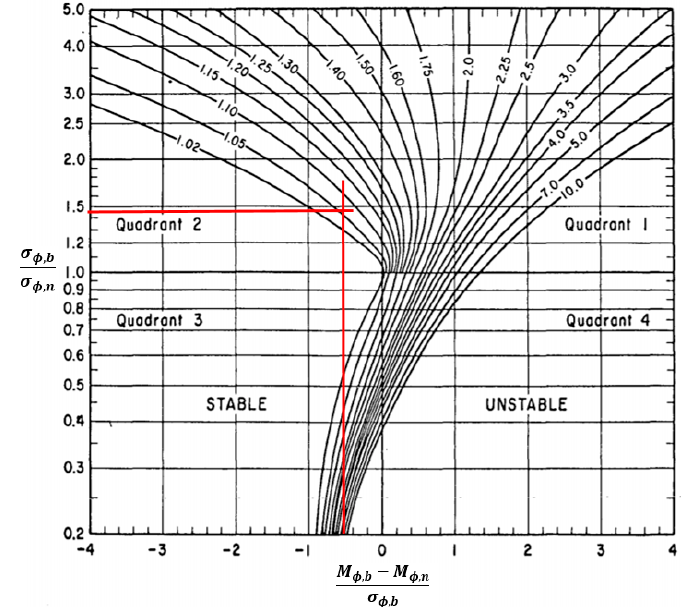
Figure 8. Evaluation of the overfill factor through the abacus of Krumbein and James.